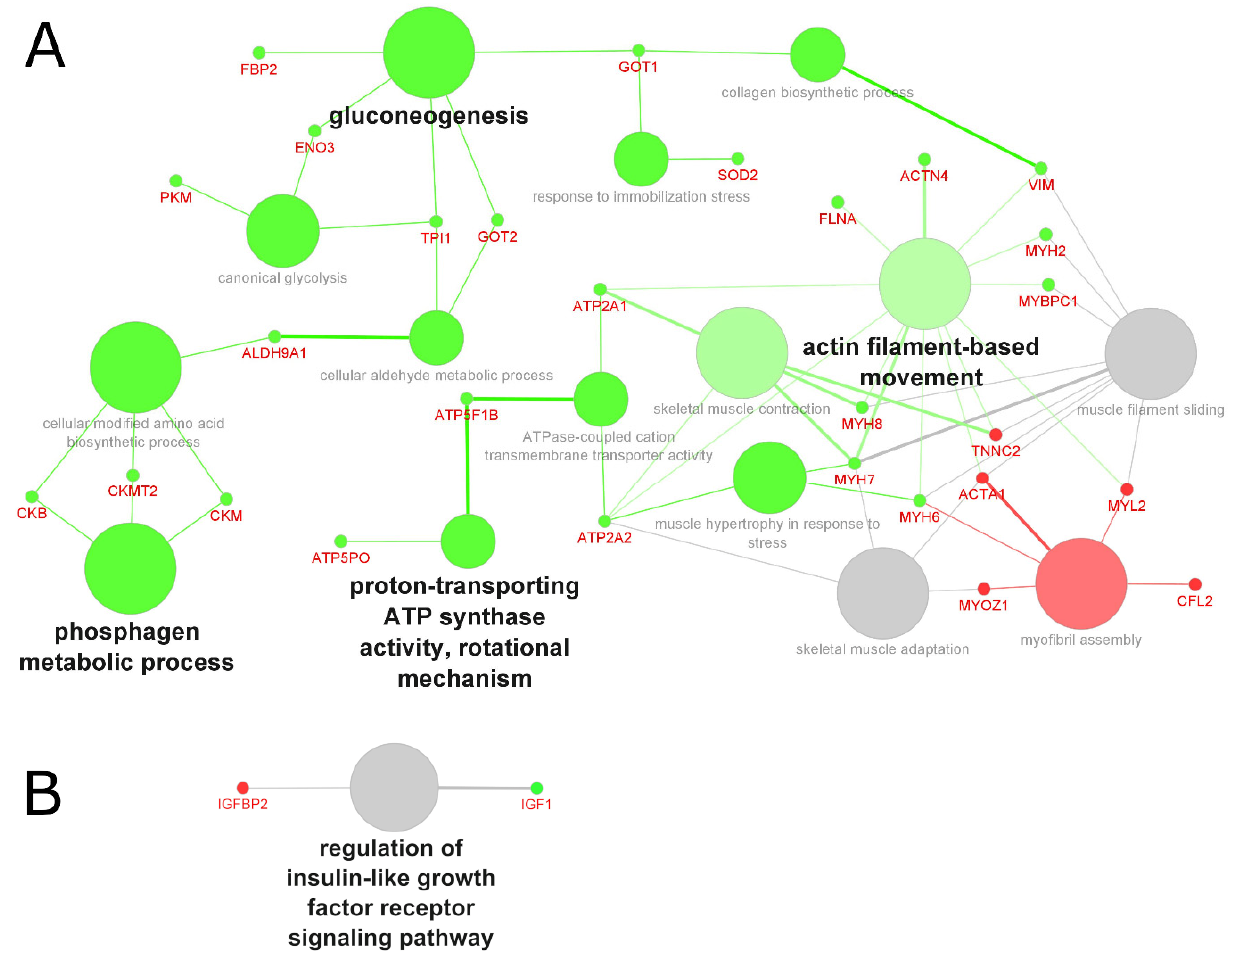
Figure 4. GO analysis of biological processes in sarcopenia-related muscle atrophy, based on grouped molecules identified in ( A ) tissue samples and ( B ) biofluid samples from 24 proteomics studies. Red nodes represent upregulated processes, green nodes represent downregulated processes, grey nodes represent common (shared) up- and downregulated processes; font and node sizes reflect statistical significance (kappa score = 0.4 and p -value < 0.01).